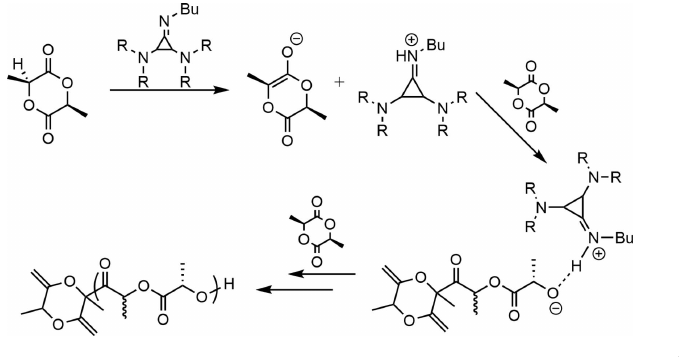
Figure 1 Catalytic ring-opening polymerization mediated by 1 .